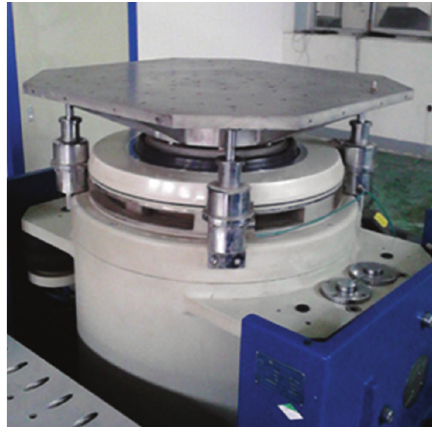
Figure 2: Air-cooled electromagnetic vibration test stand.